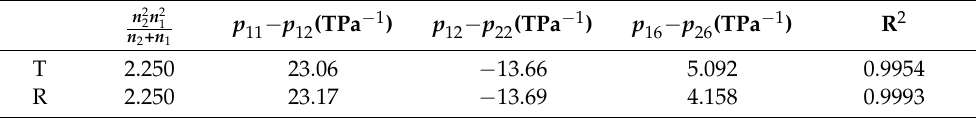
Figure 8. The relation between the isoclinic angle and the stress-optical coefficient of PET substrates. The fitting curve is compared with the experimental data. Table 3. Fitting results of the linear combinations of the photoelastic tensor components and refractive-index-related parameters.